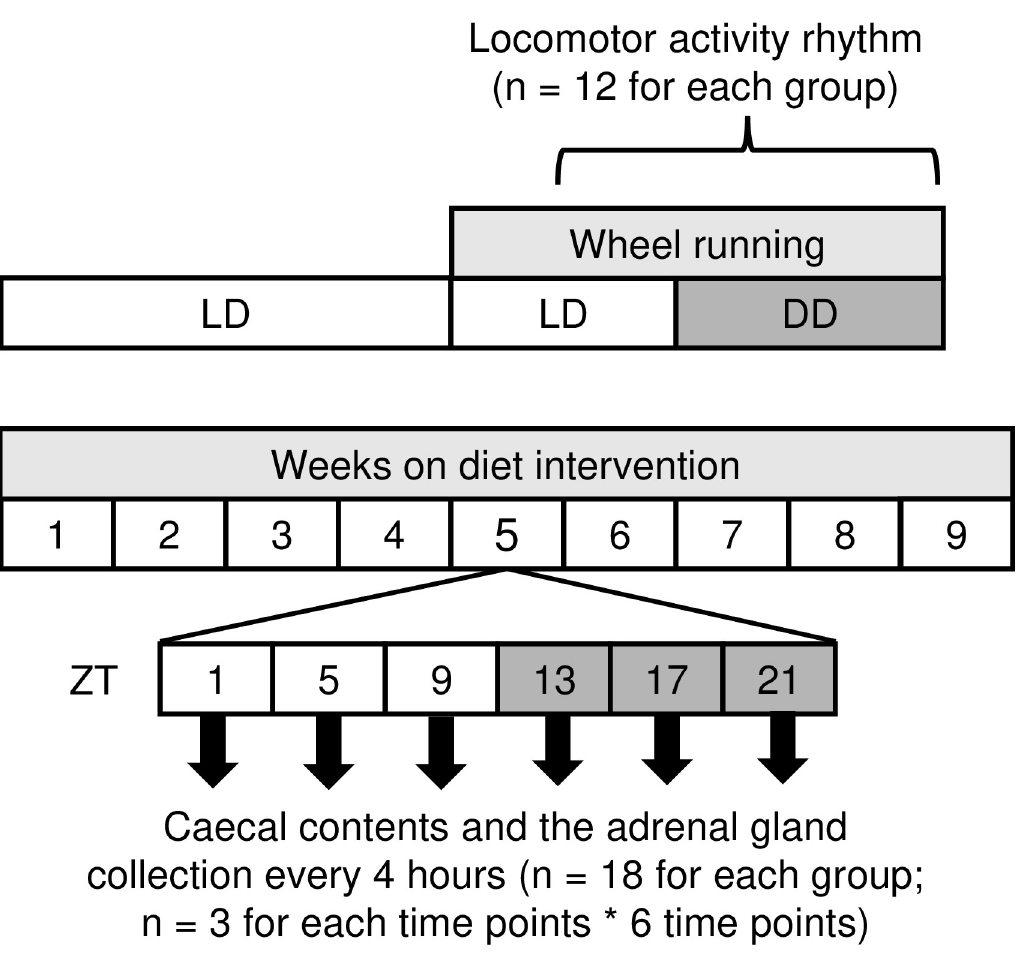
Fig 1. Flow chart of this